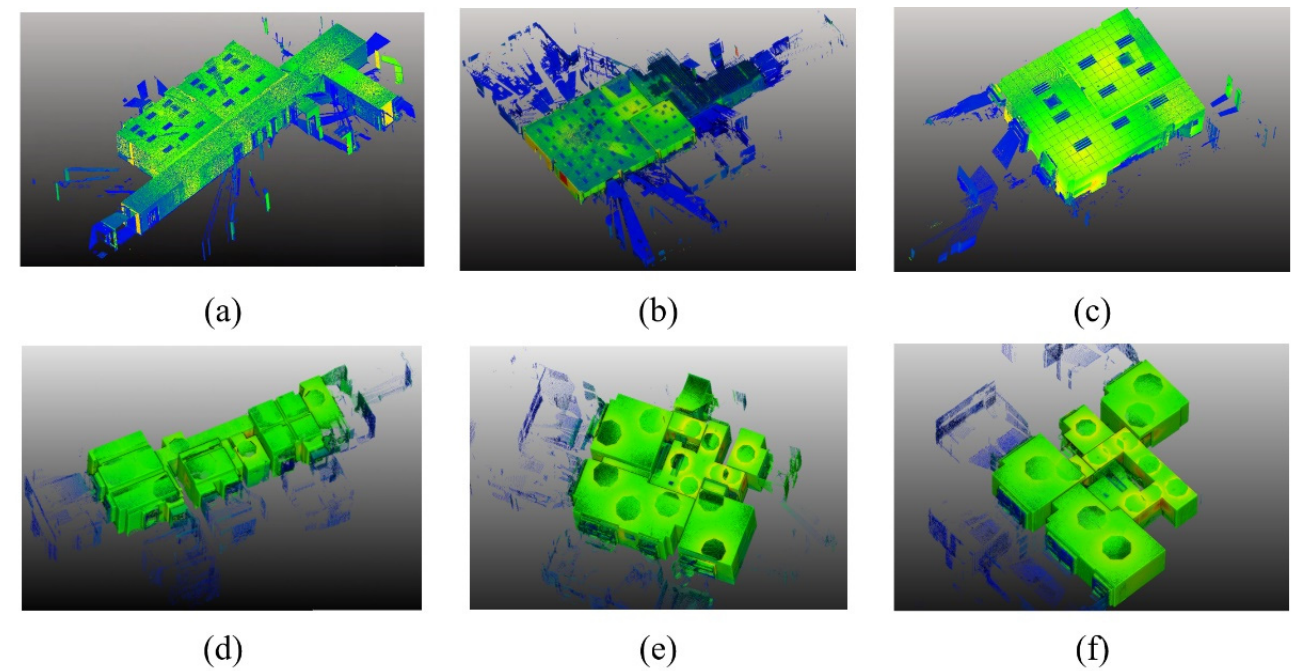
Figure 1. Registered point cloud data of six sites: ( a ) Site 1, ( b ) Site 2, ( c ) Site 3, ( d ) Site 4, ( e ) Site 5, ( f ) Site 6.